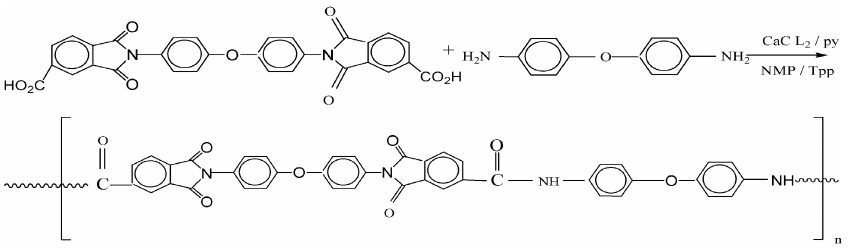
Figure 2. Synthetic route of PAI 4.